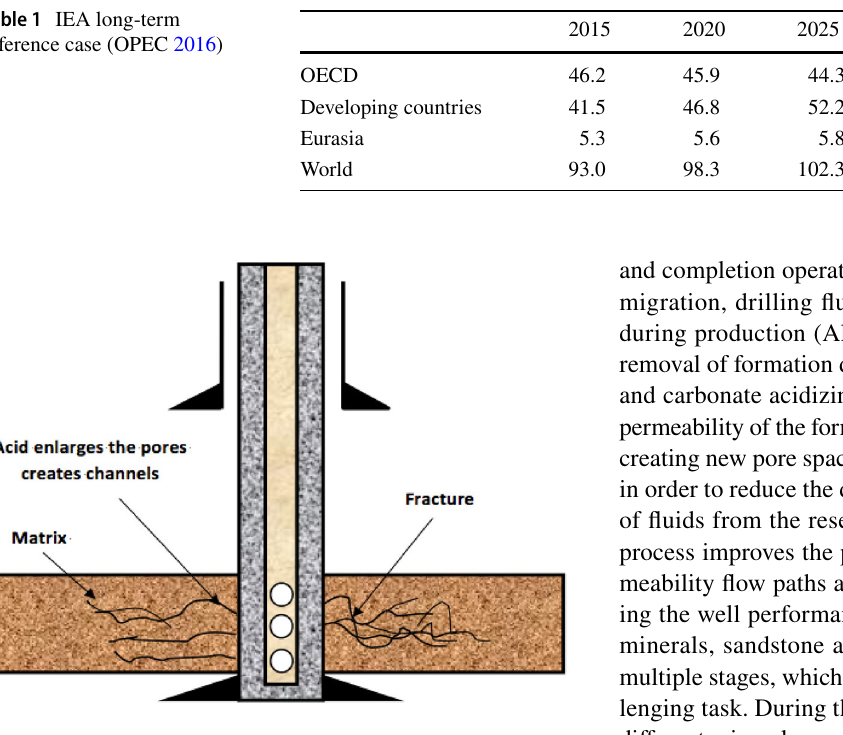
Fig. 1 Acid fracturing and matrix